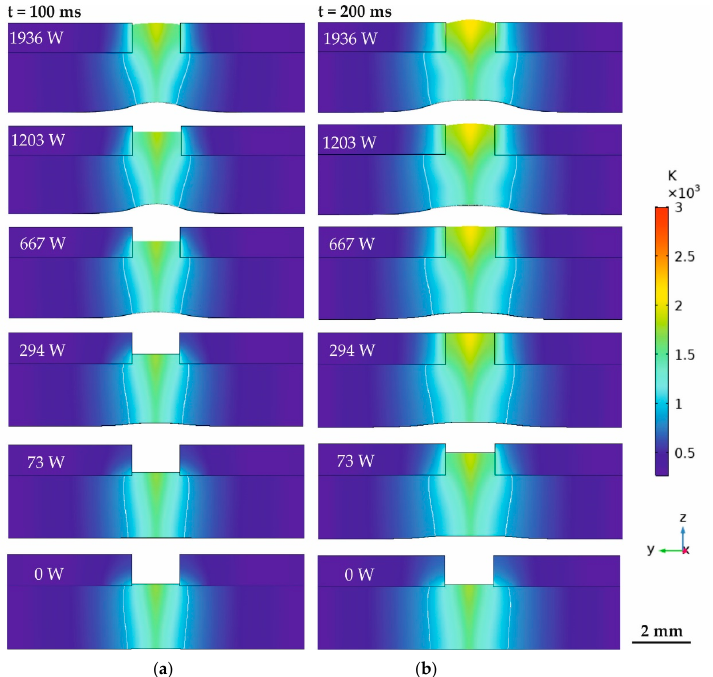
Figure 12. The numerical results of melt pool development at magnetic field powers from 0 to 1936 W and the melting isotherm (white solid line) in the symmetry plane at 100 ms ( a ) and 200 ms ( b ). The shape of the melts changes due to the influence of the electromagnetic forces. The melt pool becomes wider on the top side of the aluminium alloy sheet. The development of the melt pool flows induced by the Lorentz forces for 1936 W from 50 to 200 ms is exemplarily shown in Figure 13.